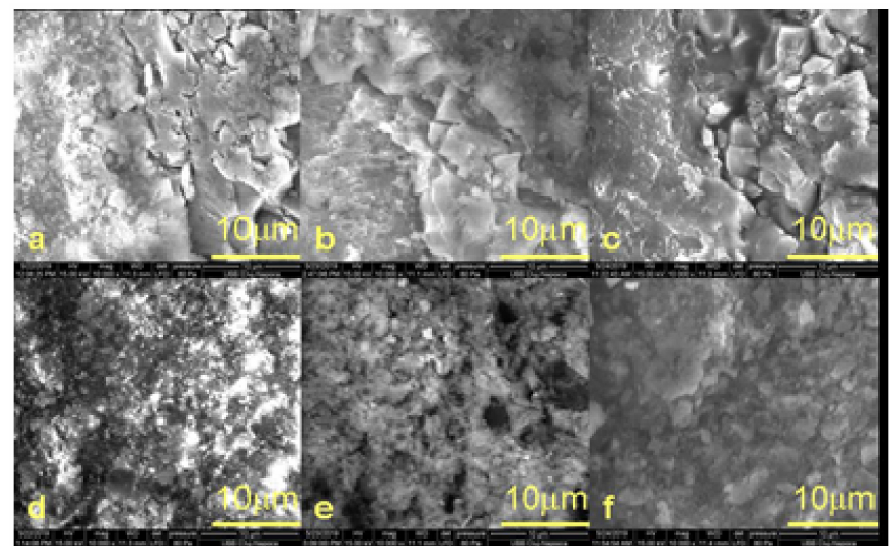
Figure 7. SEM images of the mortar surface after exposure to various corrosive solutions: ( a , d ) Rain- water (pH = 6); ( b , e ) Acetic acid (pH = 3.5); ( c , f ) Sulfuric and nitric acid (pH = 2). ( a – c ) Reference mortar (M); ( d – f ) GO-Ag-GO-Fly